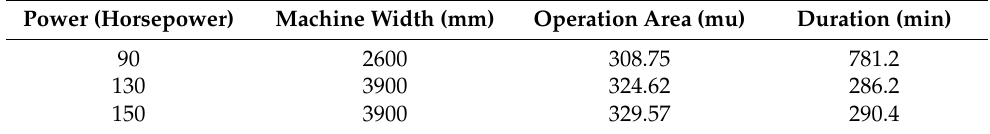
Table 2. Effect of completing the same working area with different types of agricultural machinery.